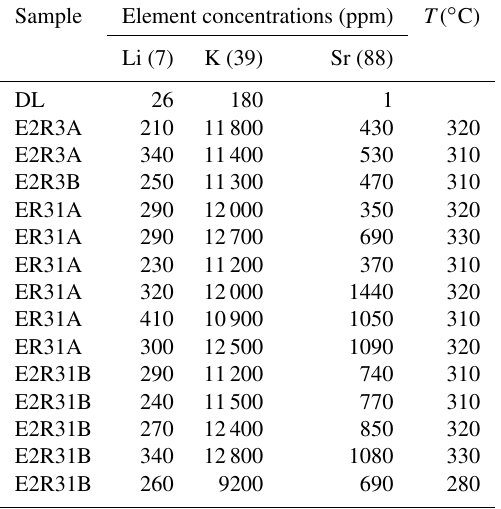
Table 2. Compositional data of fluid inclusions (QzP2) obtained from LA-ICP-MS measurements with Na fixed at 43300ppm for all inclusions. Temperatures ( T ) were estimated using the Na / K geothermometers of Can (2002).